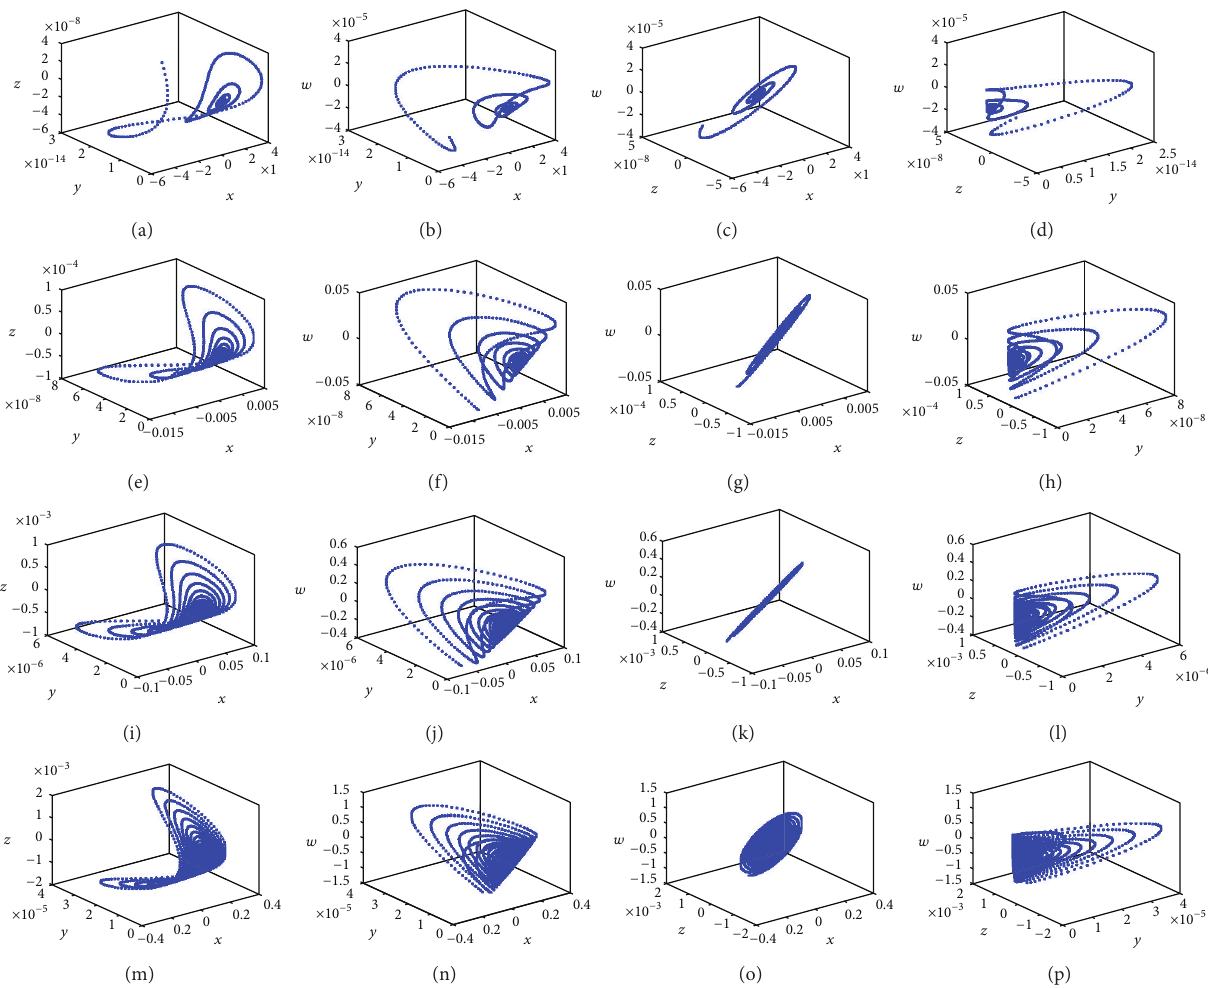
Figure 8: Typical dynamical behavior of system (1). (a)–(d): 𝑎 = −1.59 , (e)–(h): 𝑎 = −1.5 , (i)–(l): 𝑎 = −0.56 , and (m)–(p): 𝑎 = 0.2 .